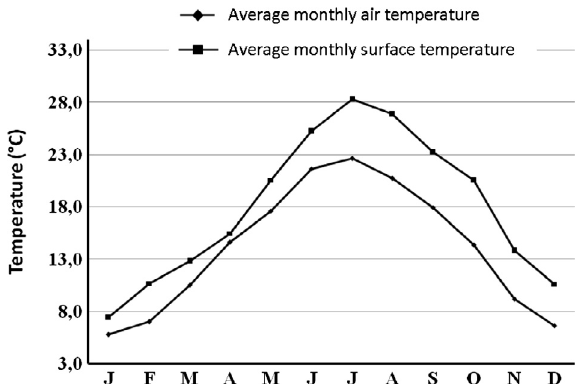
Figure 7. Average monthly air and surface soil temperature.